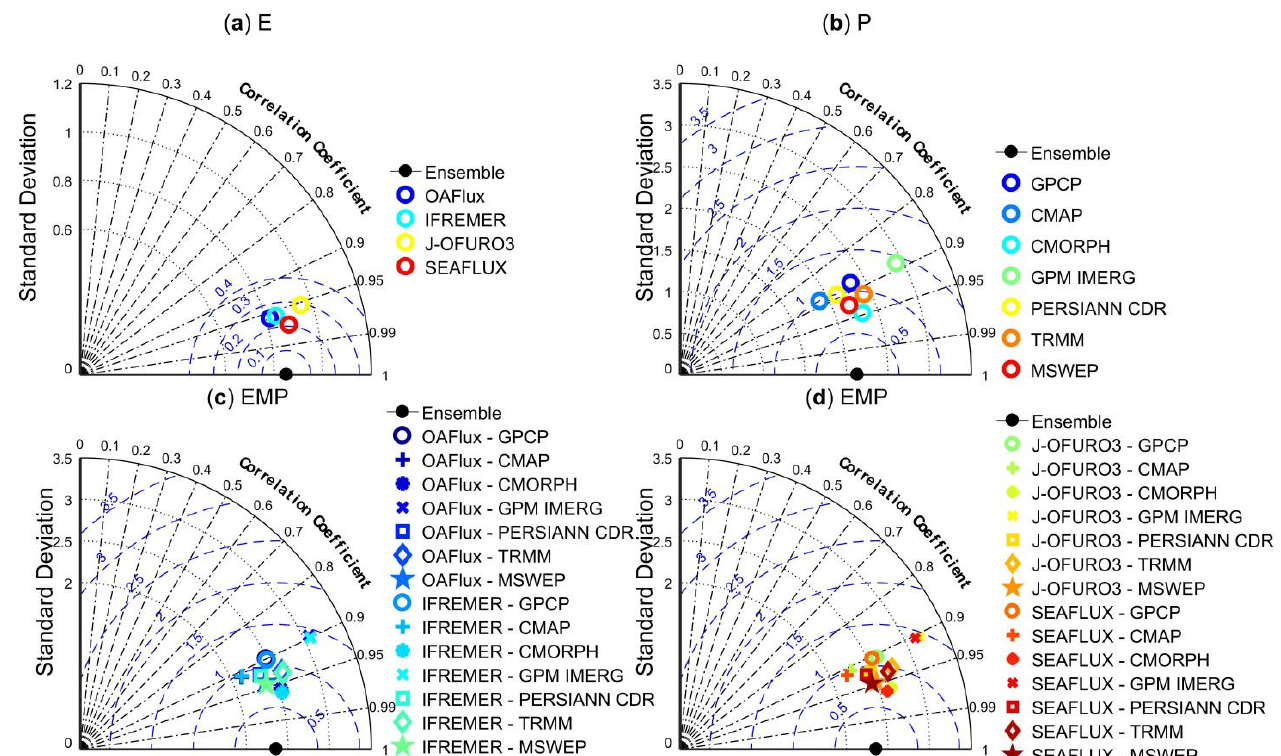
Figure 2. Area-weighted standard deviations (radial distance from the origin of the circle) and correlation coefficients (the azimuthal angle) between individual products and ensemble medians of ( a ) E, ( b ) P and ( c , d ) EMP over 50 ◦ S–50 ◦ N from 2012 to 2017. p -value < 0.05 (58 degrees of freedom) for all correlations in E , P and EMP, respectively. The standard deviations and correlations are calculated over each grid point and then are area-averaged over the global ocean. ( c , d ) denote Taylor diagrams of EMP, but with different datasets; they are plotted here for easier visualization. The blue dashed lines denote the root mean square difference (RMSD). The units for STD and RMSD are mm/day.